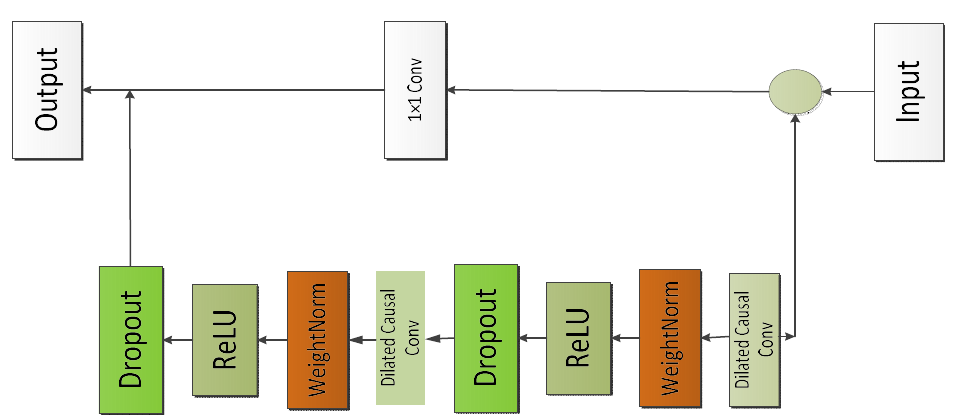
Figure 2. TCN residual block. The 1 × 1 convolution is added when the input and output sizes of the residual block are not the same.